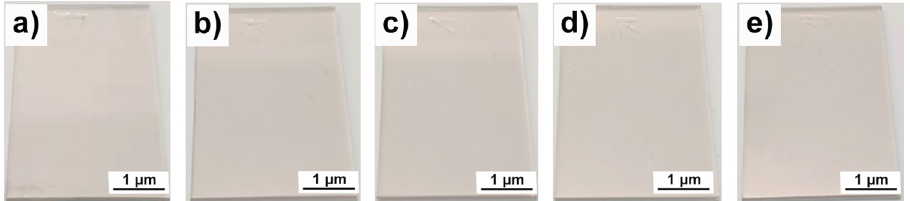
Figure 1: Optical pictures of CSG and NBs@CSG sheets: ( a ) CSG original sample; etched - CSG after etching for di ff erent time: ( b ) 1 h, ( c ) 2 h, ( d ) 3 h, and ( e ) 4